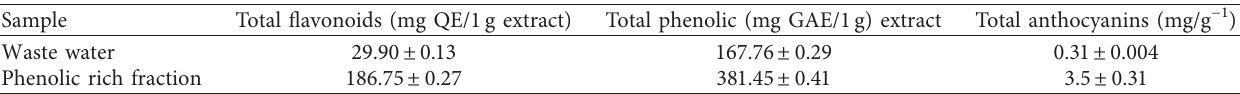
Table 1: Total phenolic, total flavonoids, and total anthocyanin content of waste water before and after (phenolic rich fraction) loading on the column.